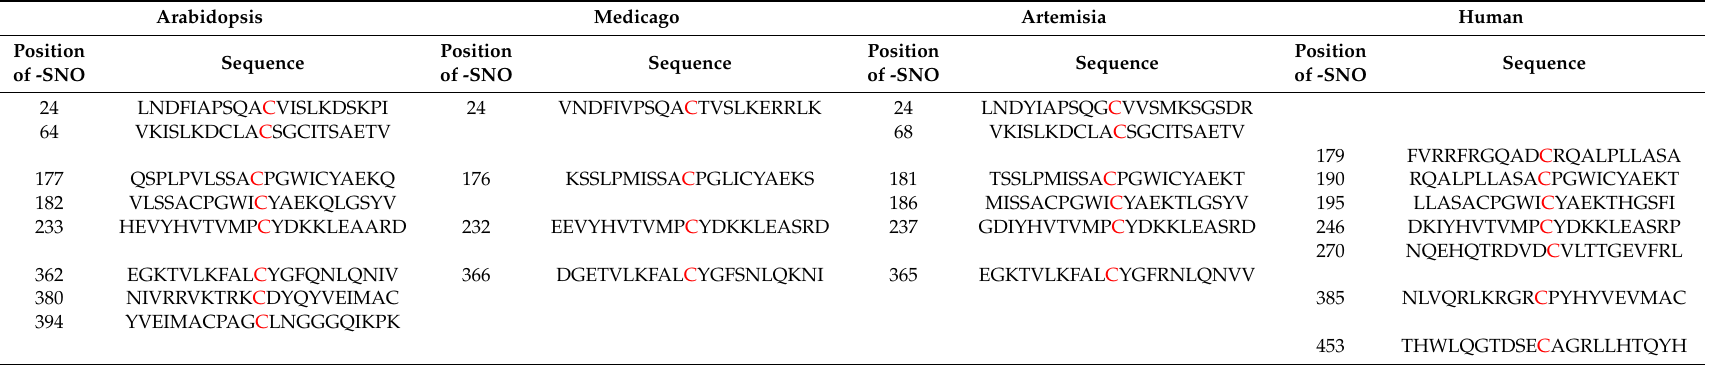
Table 1. S -nitrosation sites in four hydrogenase proteins predicted using the iSNO-PseAAC prediction tool (http: // app.aporc.org / iSNO-PseAAC / ) [35]. Arabidopsis: ferredoxin hydrogenase ( Arabidopsis thaliana ) NP_567496.4; Medicago: protein NAR1 ( Medicago truncatula) XP_003606579.2; Artemisia: ferredoxin hydrogenase ( Artemisia annua ) PWA71961.1; Human: cytosolic iron-sulfur assembly component 3 isoform 1 ( Homo sapiens ) NP_071938.1. Alignment table signifies that the regions are aligned in the amino acid sequences (highlighted in Figure 1). Target cysteine residues which may become -SNO are highlighted here in red. -SNO: nitrosated